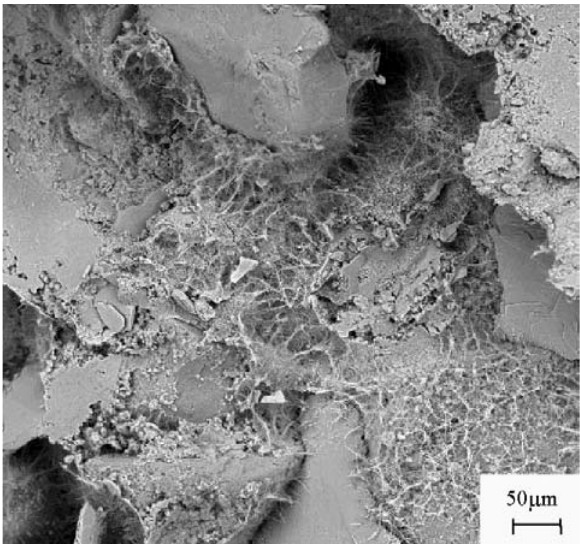
Figure 4. SEM micrograph of the morphology of the as received grit.